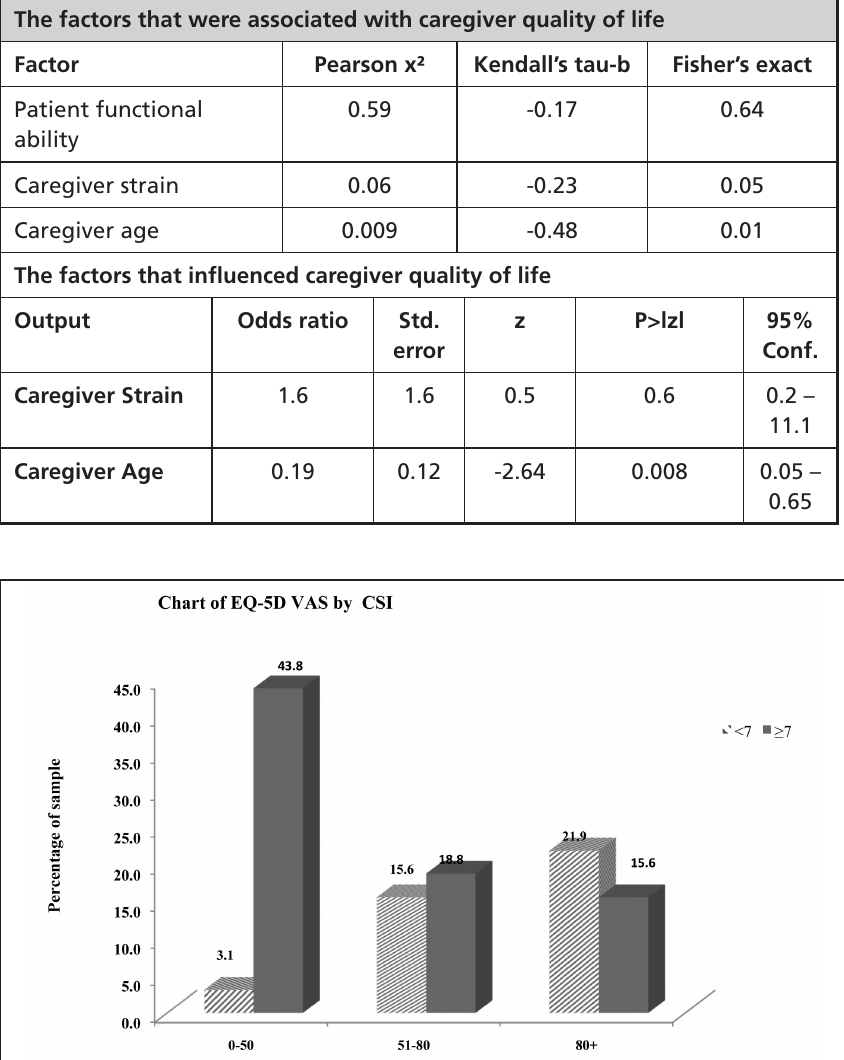
Table 3: The factors that were associated with and that influenced caregiver quality of life